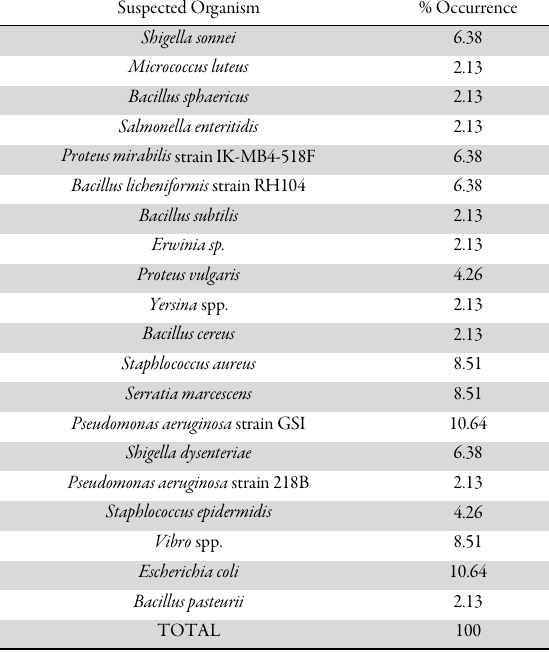
Table 6. Bacterial frequency distribution among sampling